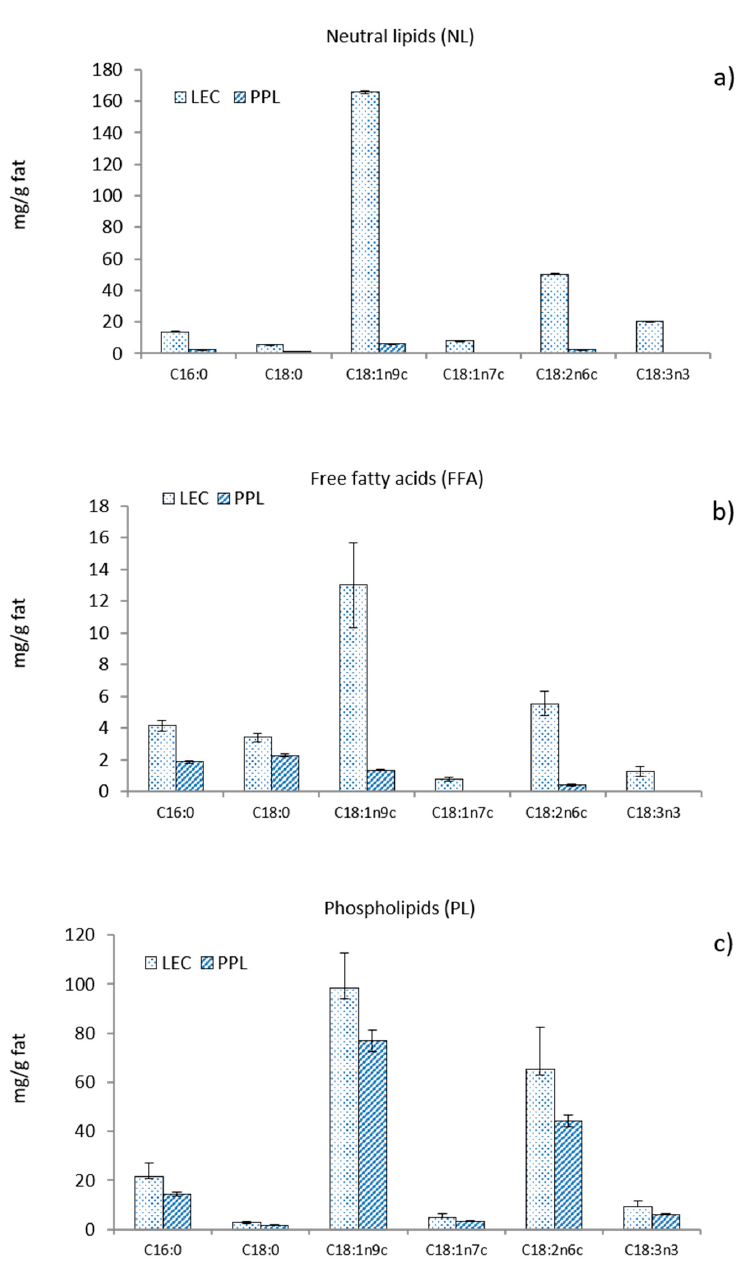
Figure 1. Fatty acid composition of ( a ) neutral lipids, ( b ) free fatty acids, and ( c ) phospholipids from commercial rapeseed lecithin (LEC) and partially purified phospholipid fraction